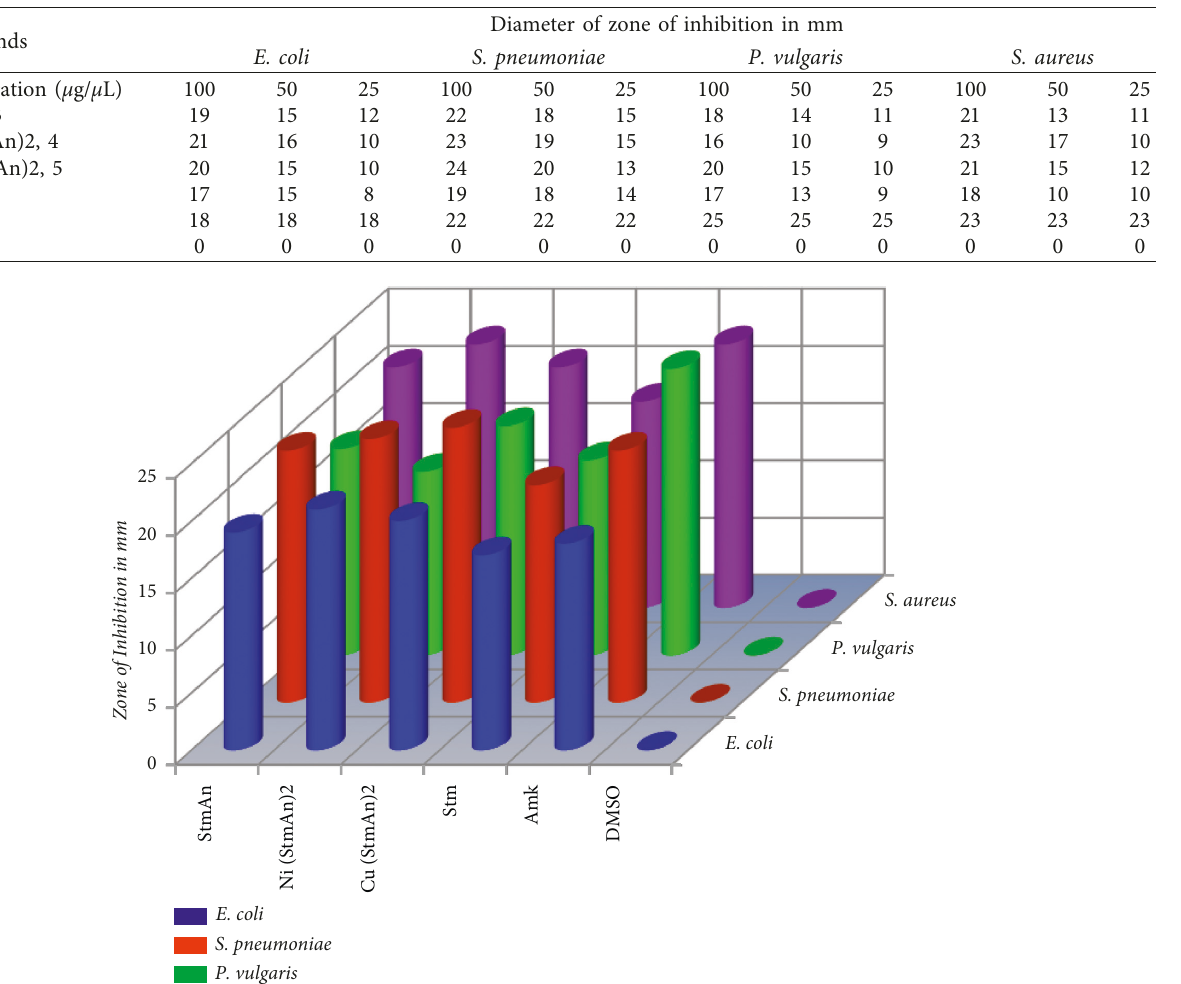
Table 4: Antibacterial activity data.